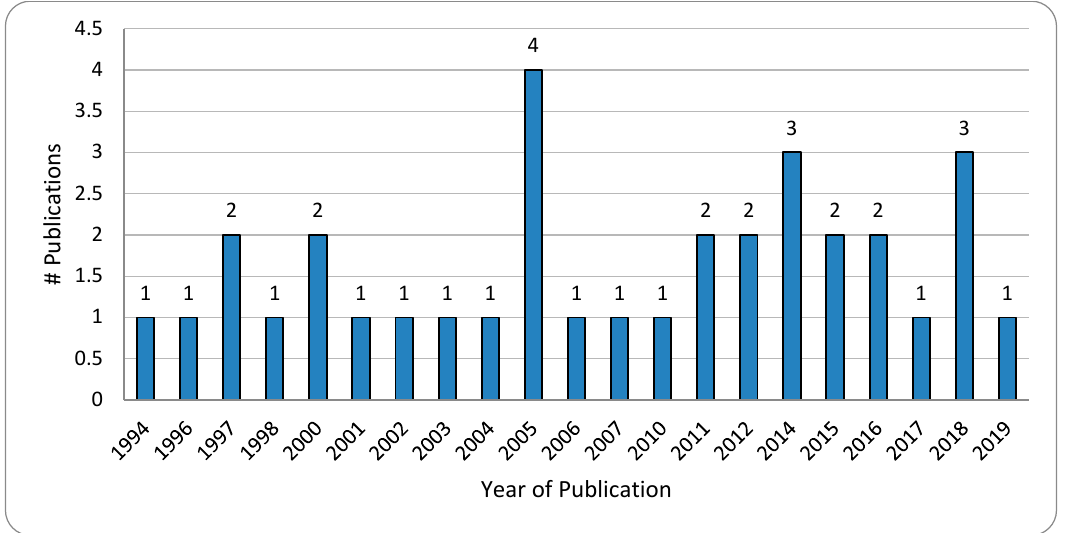
Figure 2. Year-wise classification of included articles.